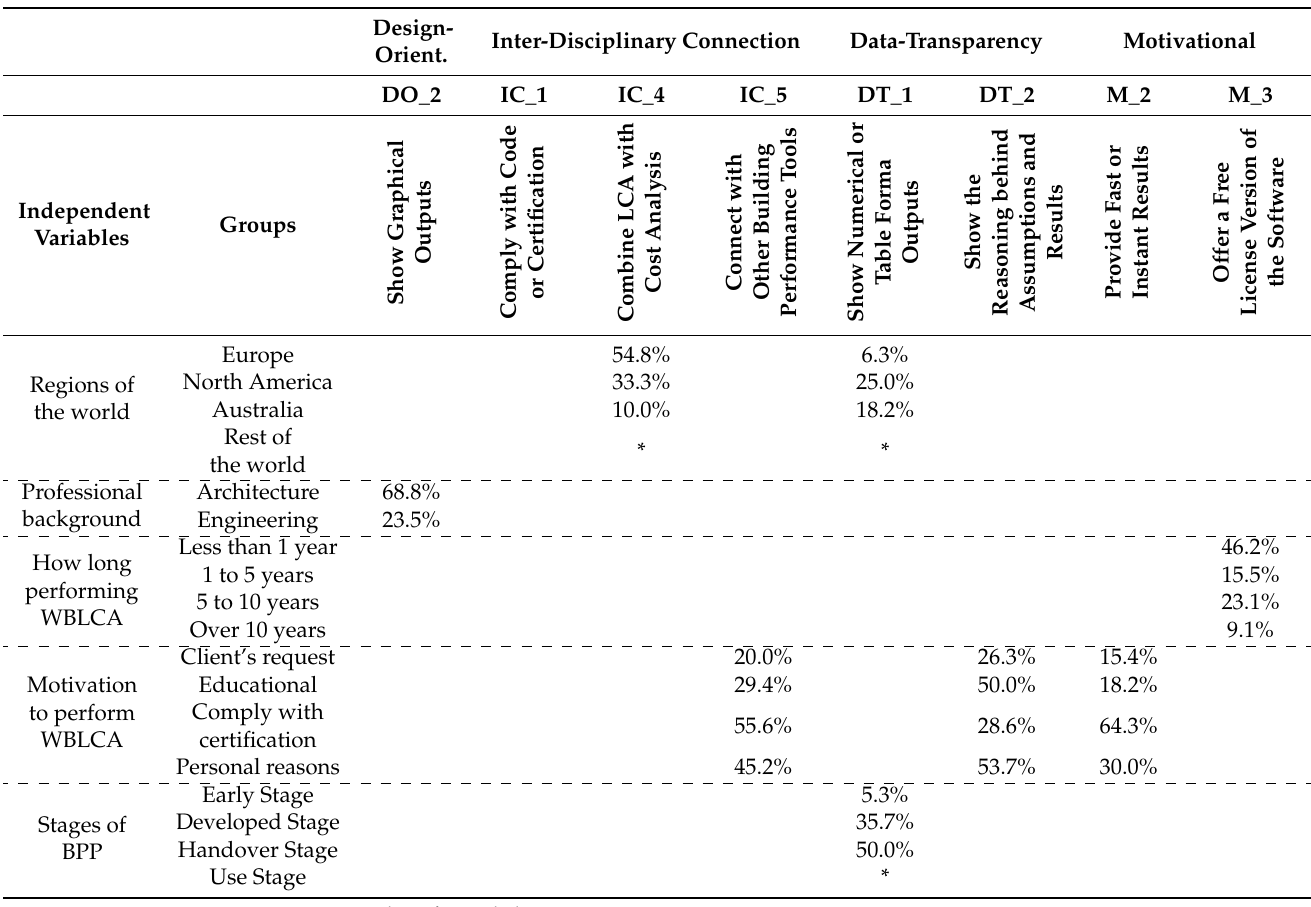
Table 6. Wish it had ( WIH ) percentages within different